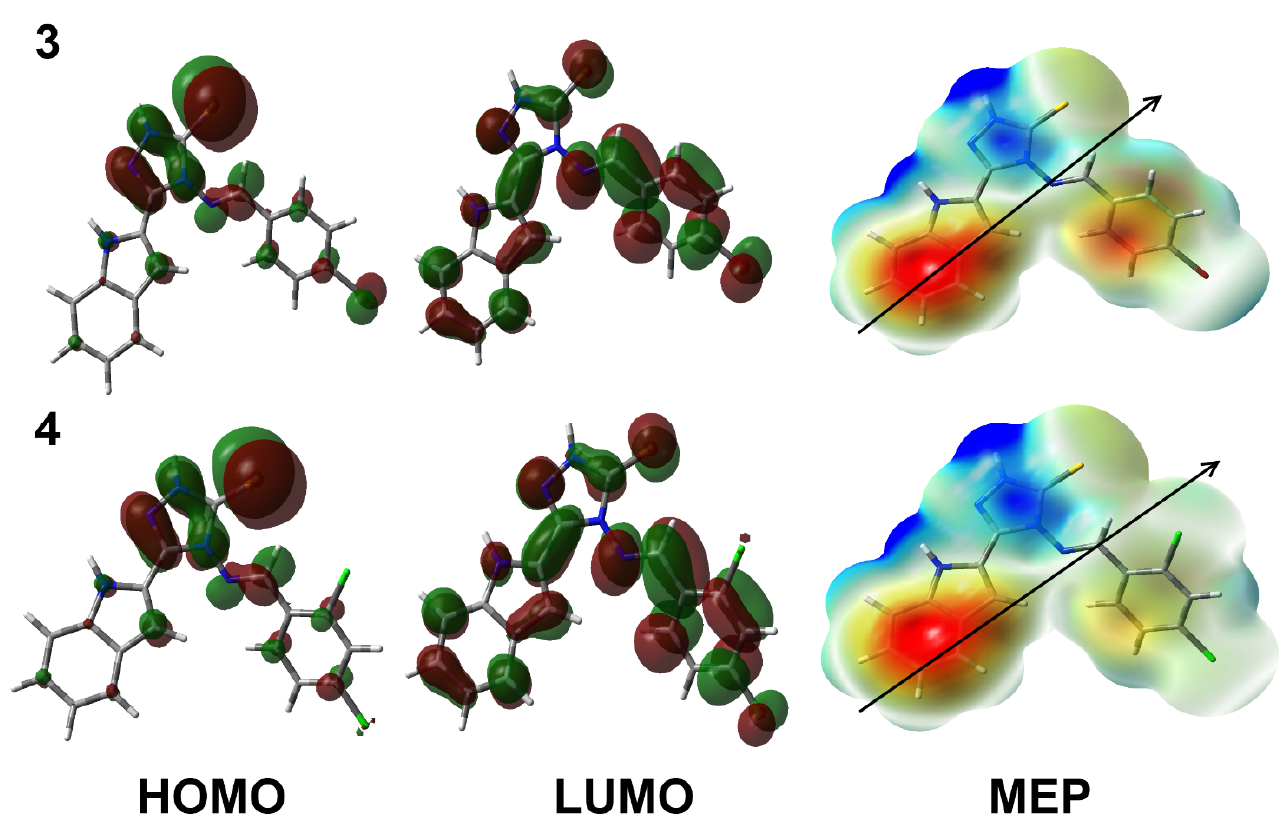
Figure 14. The MEP, HOMO and LUMO for the studied compounds.